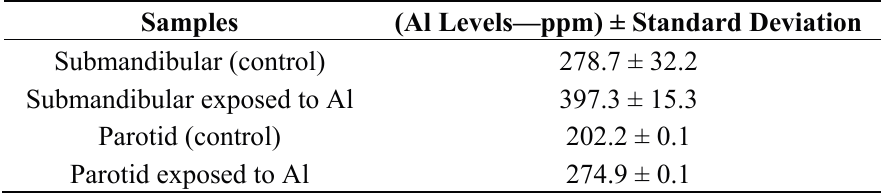
Table 1. Measurement of the average levels of Al deposition in the salivary glands represented in μ g·g − 1 ± standard